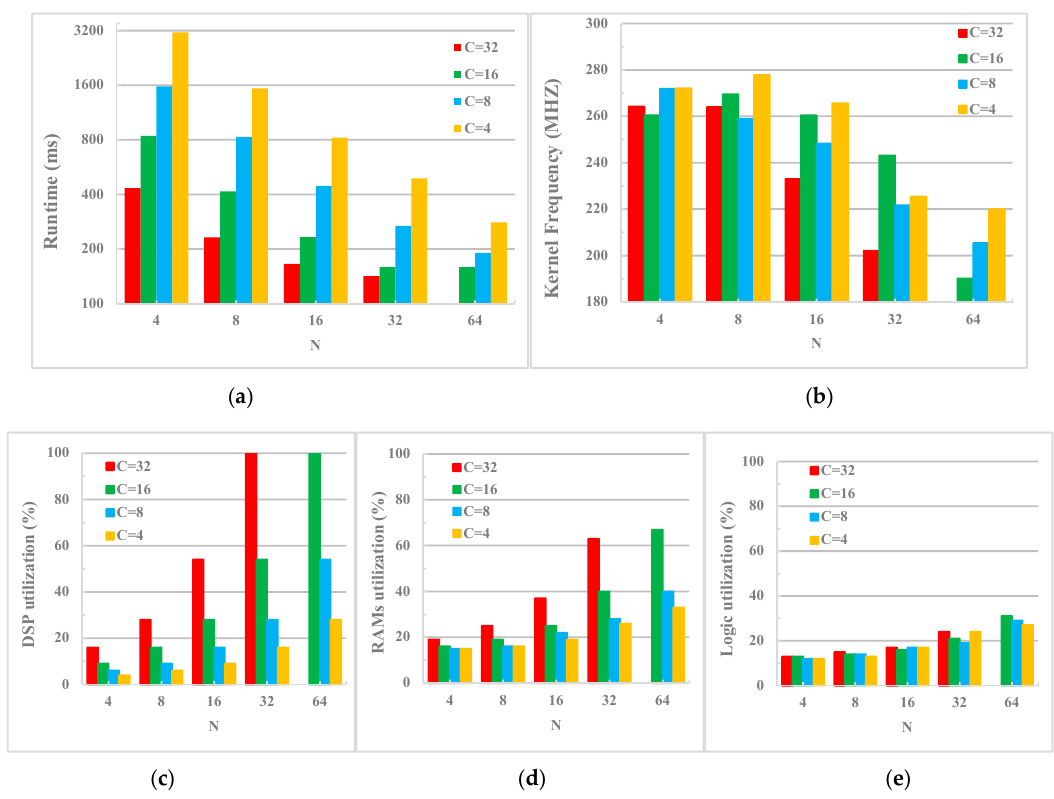
Figure 8. Design space exploration results for EDSSA on the Arria-10 GX1150. ( a ) Runtime; ( b ) Frequency; ( c ) DSP utilization; ( d ) RAMs utilization; ( e ) Logic utilization.